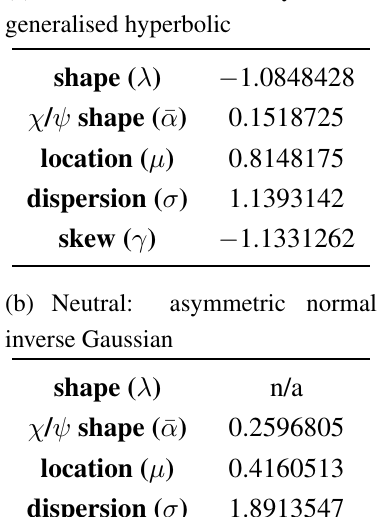
Table S2. Maximum likelihood estimates of parameters for models of normalised GM displaying lowest AIC. Parameter variables are for the R package ghyp